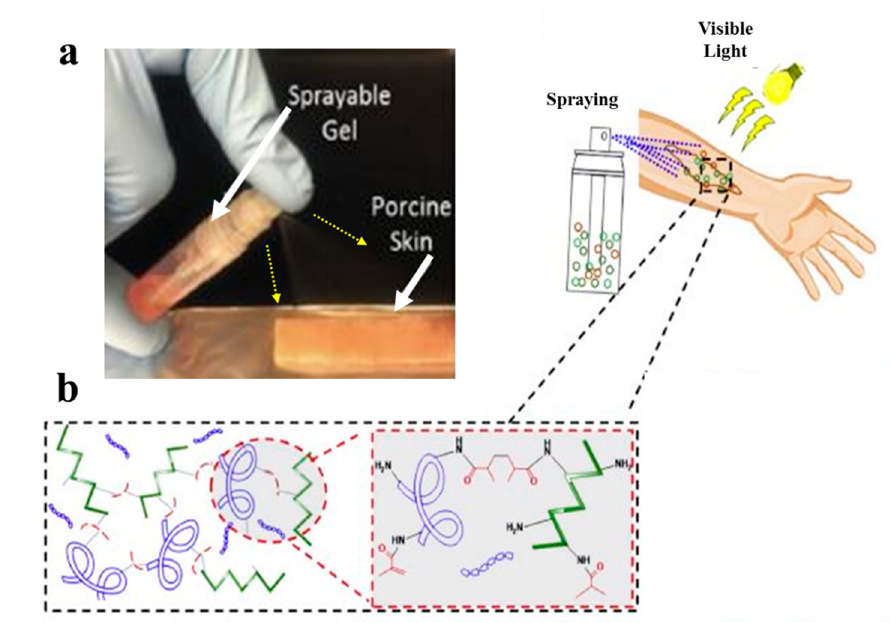
Figure 3. ( a ) Spraying of the MeTro / GelMA composite hydrogel on a porcine skin and the crosslinking process of the MeTro / GelMA under visible light exposure; ( b ) MeTro / GelMA monomers and their bonds under light exposure [65] .